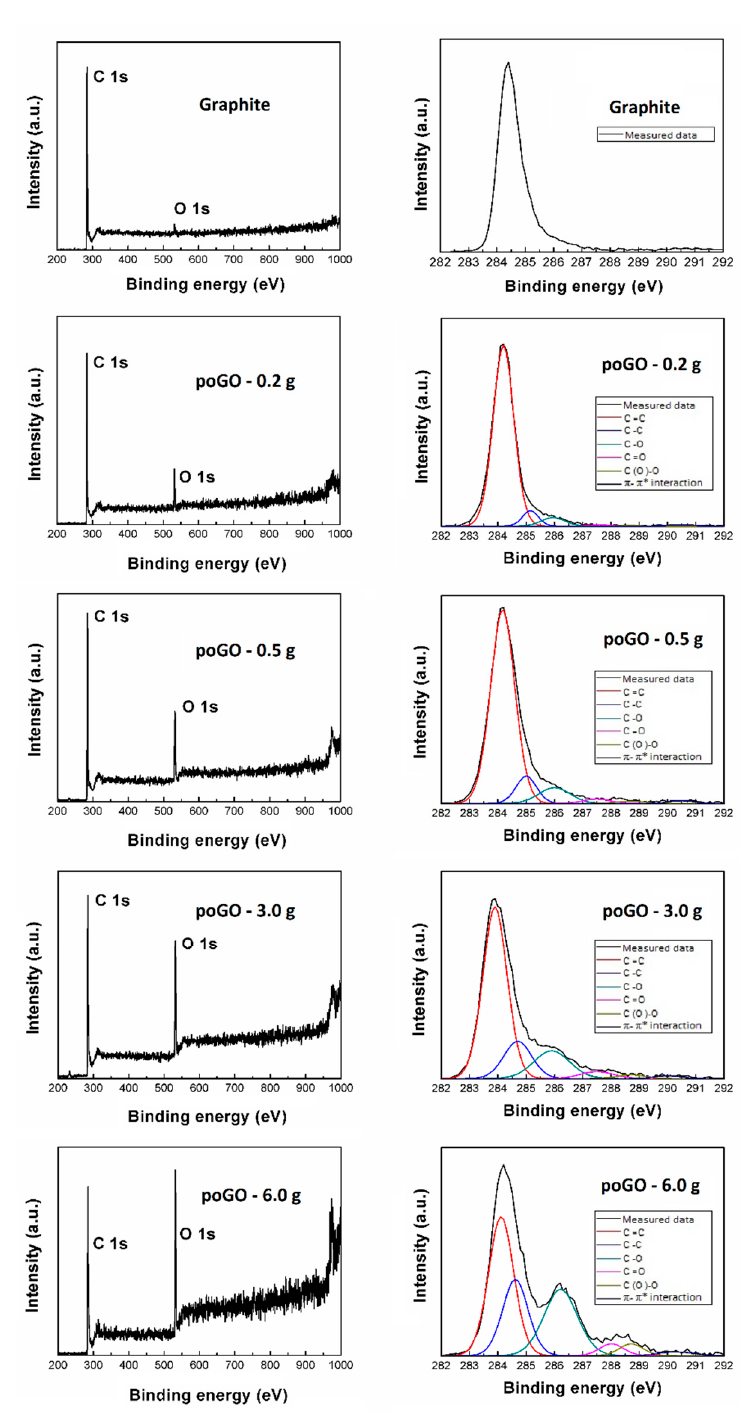
Figure 2. XPS spectra of poGOs: survey spectra (left) and C1s details (right).